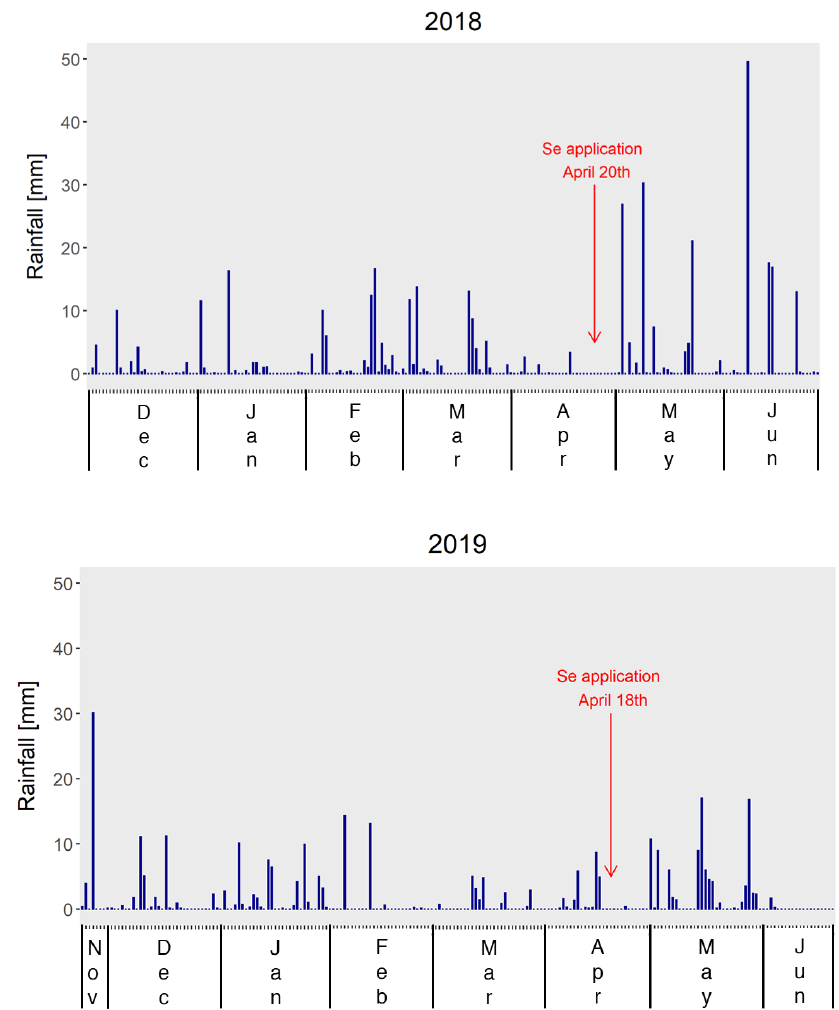
Figure 1. Daily rainfall for the two growing